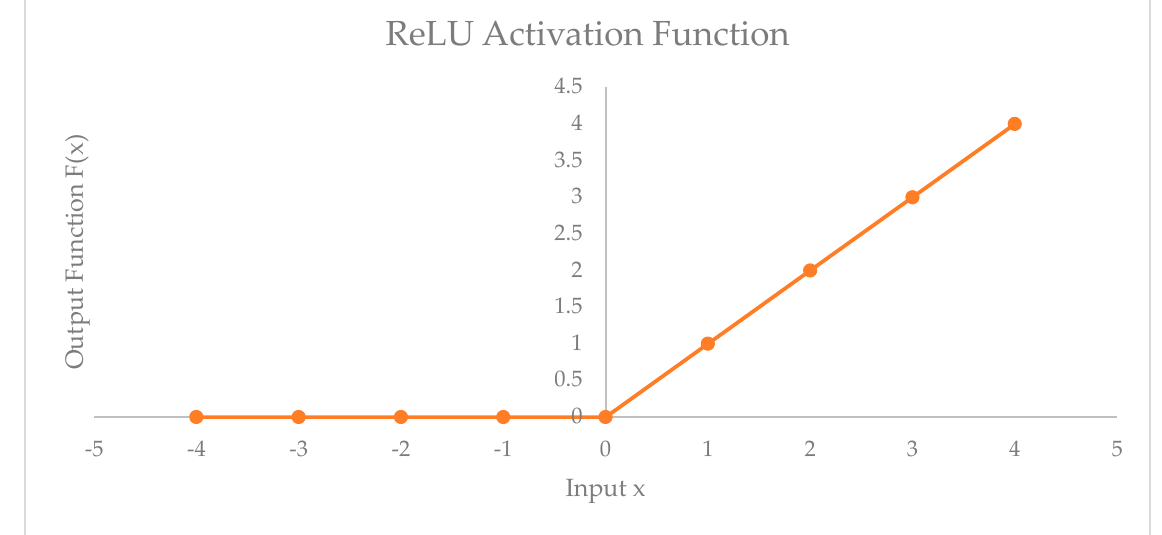
Figure 5. Graphical representation of the ReLU activation function.